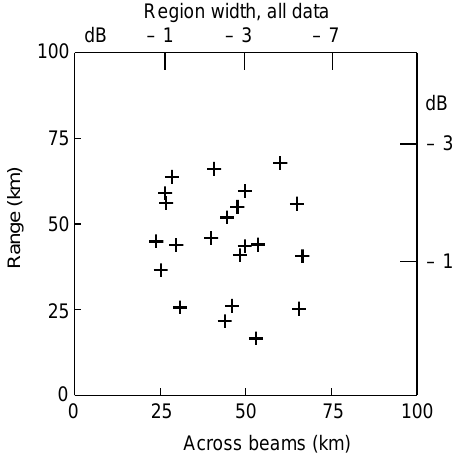
Fig. 6. Observations for 22–26 April 1996. The scatter plot represents the width of the heated region along CUTLASS beam 5 against the width across CUTLASS beams 3–7. The dB scale indicates the level of power in dB down from the centre of the